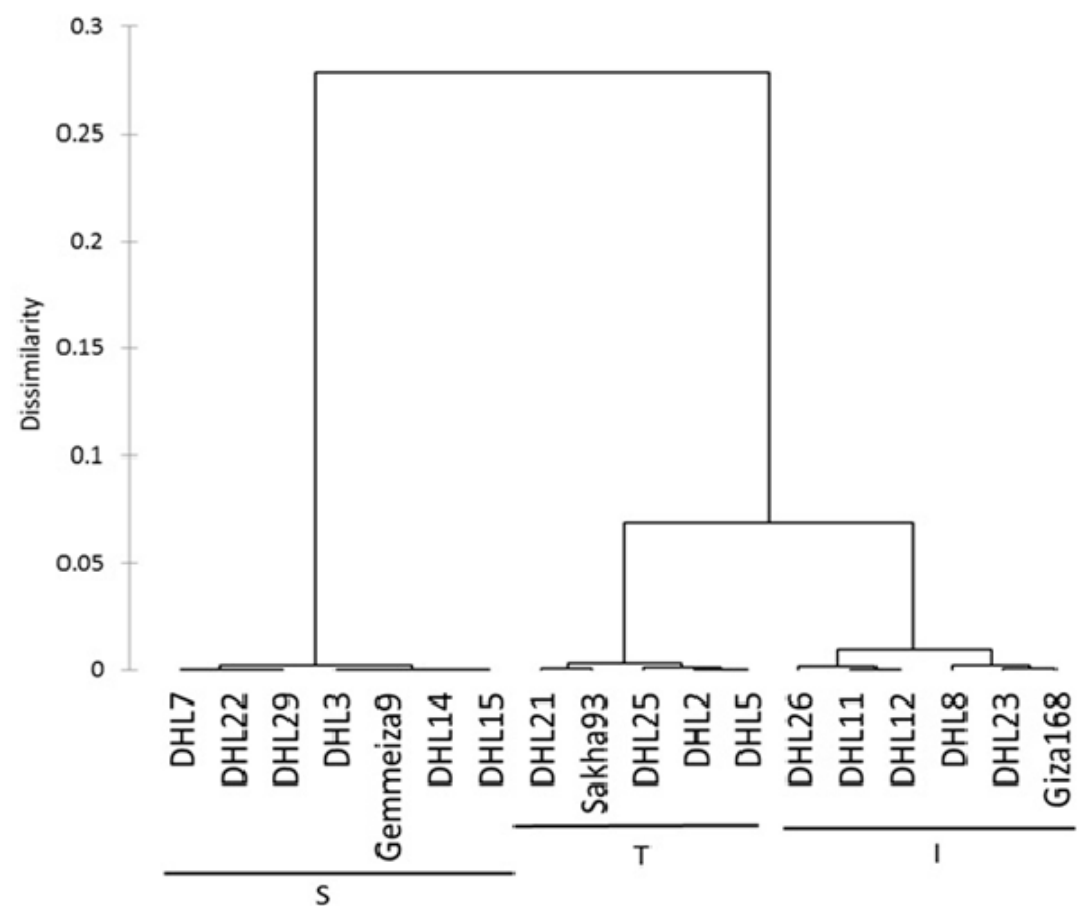
Figure 1. Dendrogram showing clustering of 18 wheat genotypes based on the Euclidean distance of relative change of relative turgidity and shoot dry matter traits. DHL: doubled haploid line, T: tolerant, I: intermediate, and S: sensitive.